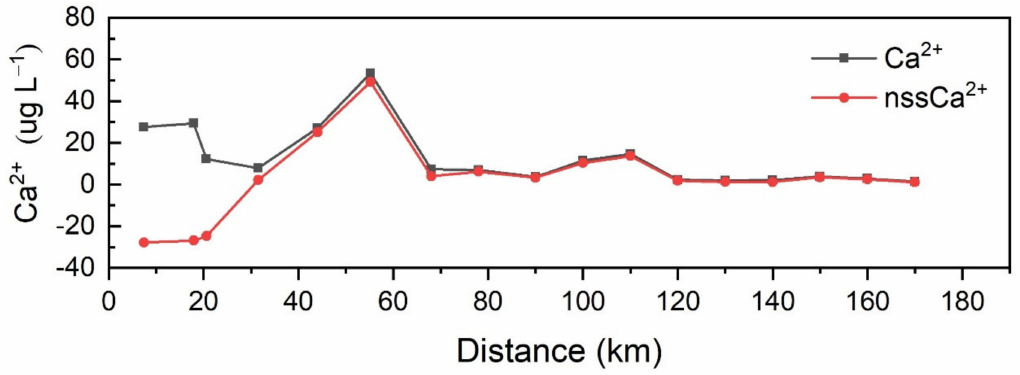
Figure 7. Concentration variations of Ca 2+ and nssCa 2+ with increasing distance from the